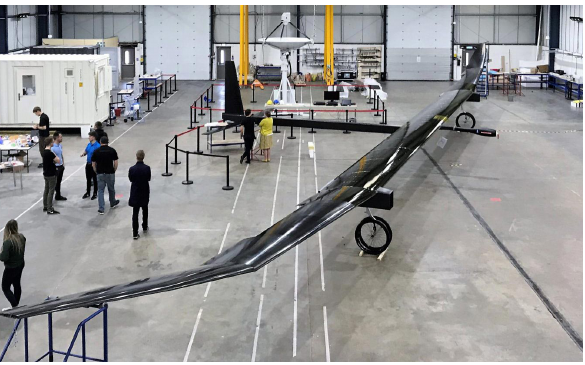
Figure 3. Prepared UAV PHASA-35 in hangar built by Prismatic for BAE Systems